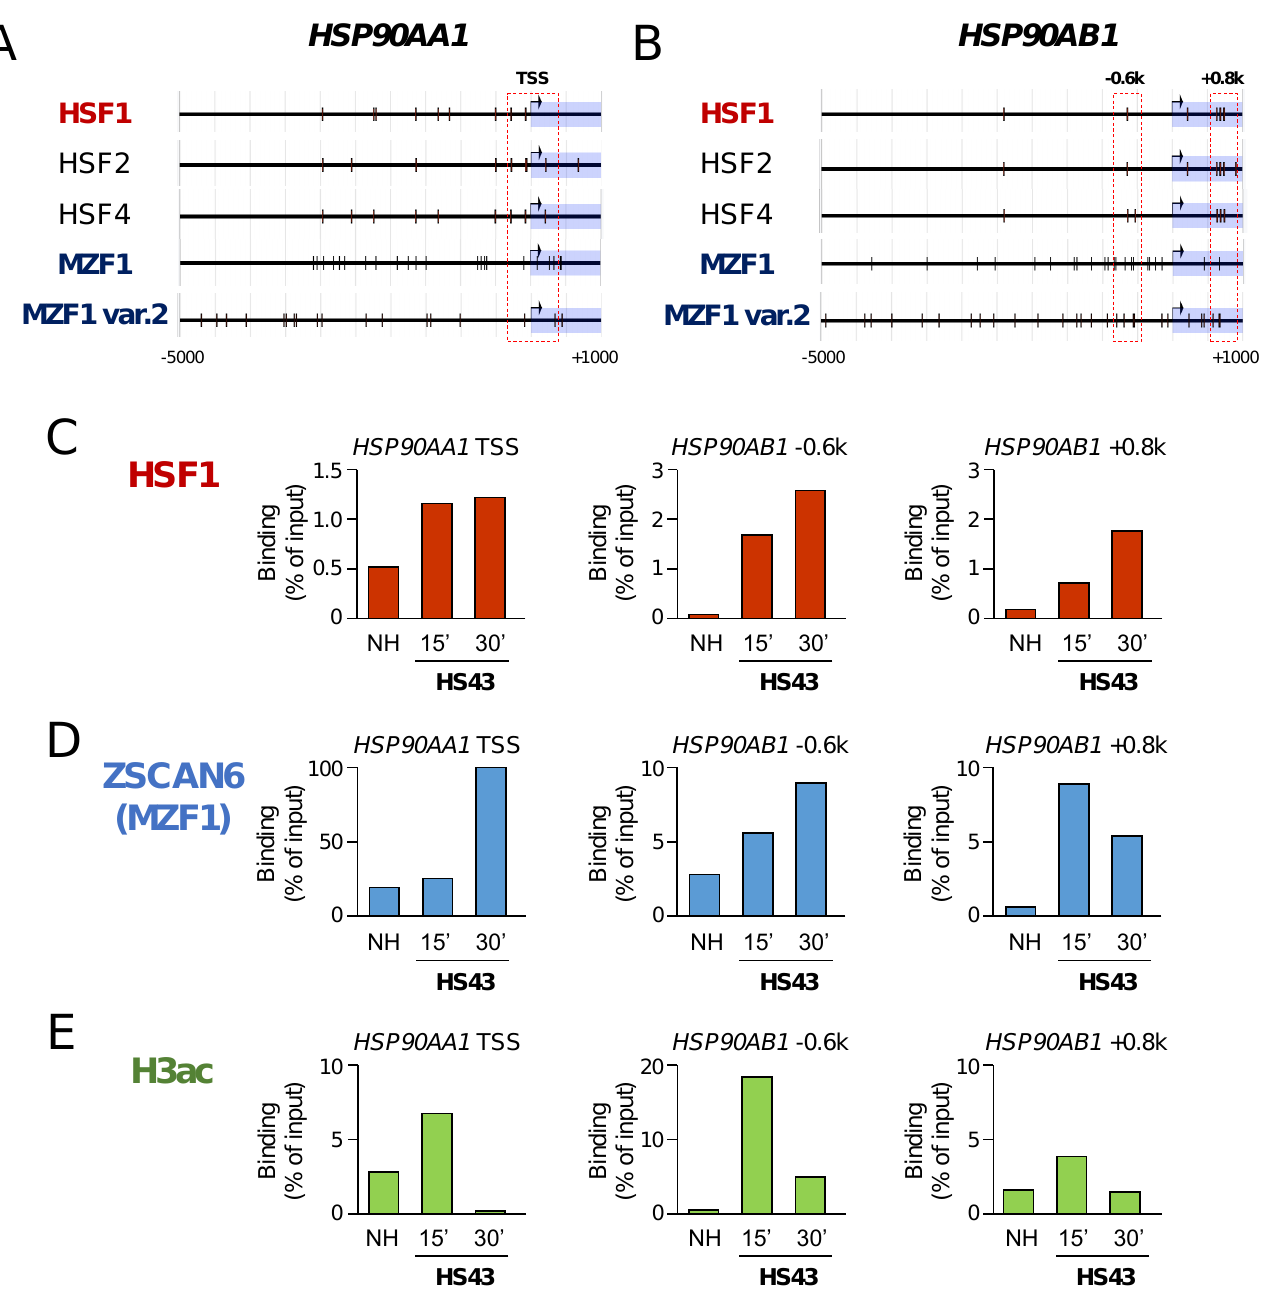
Heat shock stress induces HSF1 and MZF1(ZSCAN6) binding to HSP90 genes. ( A , B ) Promoter regions ( − 5000 to +1000) of the HSP90AA1 gene ( A ) and the HSP90AB1 gene ( B ) mapped with binding sites of HSFs and MZF1(ZSCAN6). Black vertical bars indicate bind- ing sites. Hatched boxes indicate regions analyzed by ChIP-qPCR. ( C – E ) ChIP-qPCR assay. PC-3 cells were treated with heat shock at 43 ◦ C (HS43) for 15 or 30 min or non-heated (NH), and chromatin was fixed. ChIP was performed using antibodies against HSF1 ( C ), MZF1/ZSCAN6 ( D ) and acetylated histone H3 (H3ac) ( E ) for qPCR of HSP90